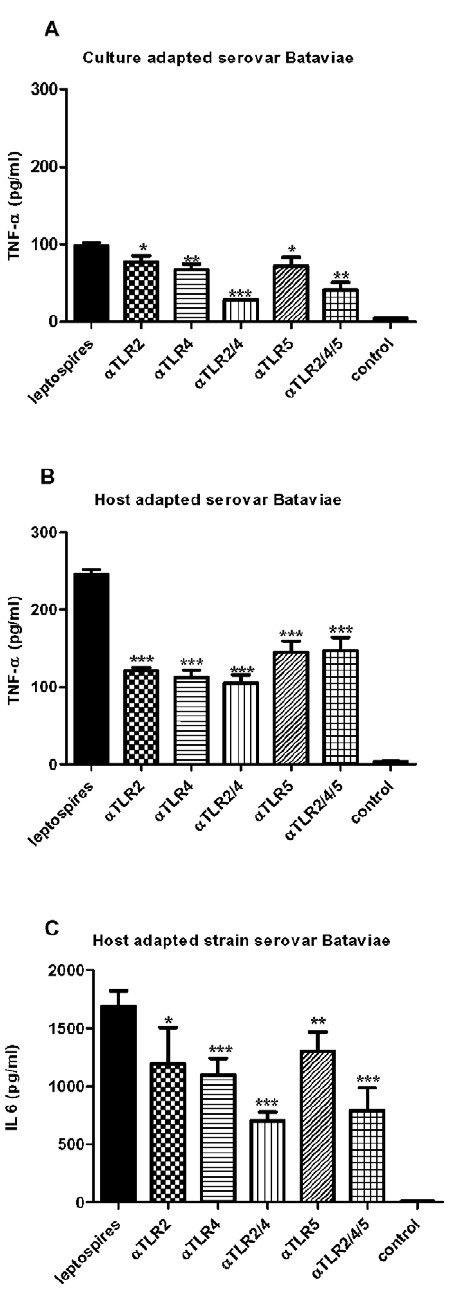
Figure 5. TLR2, TLR4 and TLR5 mediate activation of whole blood in response to live leptospires. Whole blood was stimulated with 2.5 6 10 5 /ml leptospires of host- and culture-adapted serovar Bataviae in the presence of anti-TLR2, anti-TLR4 and anti-TLR5 antibodies. Data represent mean TNF- a and Il-6 values. Error bars represent the standard deviation (SD) of the mean. Asterisks represent the significance: p value , 0.001 ***, 0.001–0.01 **, 0.01-0.05 * compared to the control. Panel A: TNF- a response of culture-adapted serovar Bataviae. Panel B: TNF- a response of host-adapted serovar Bataviae. Panel C: IL-6 response of host-adapted serovar